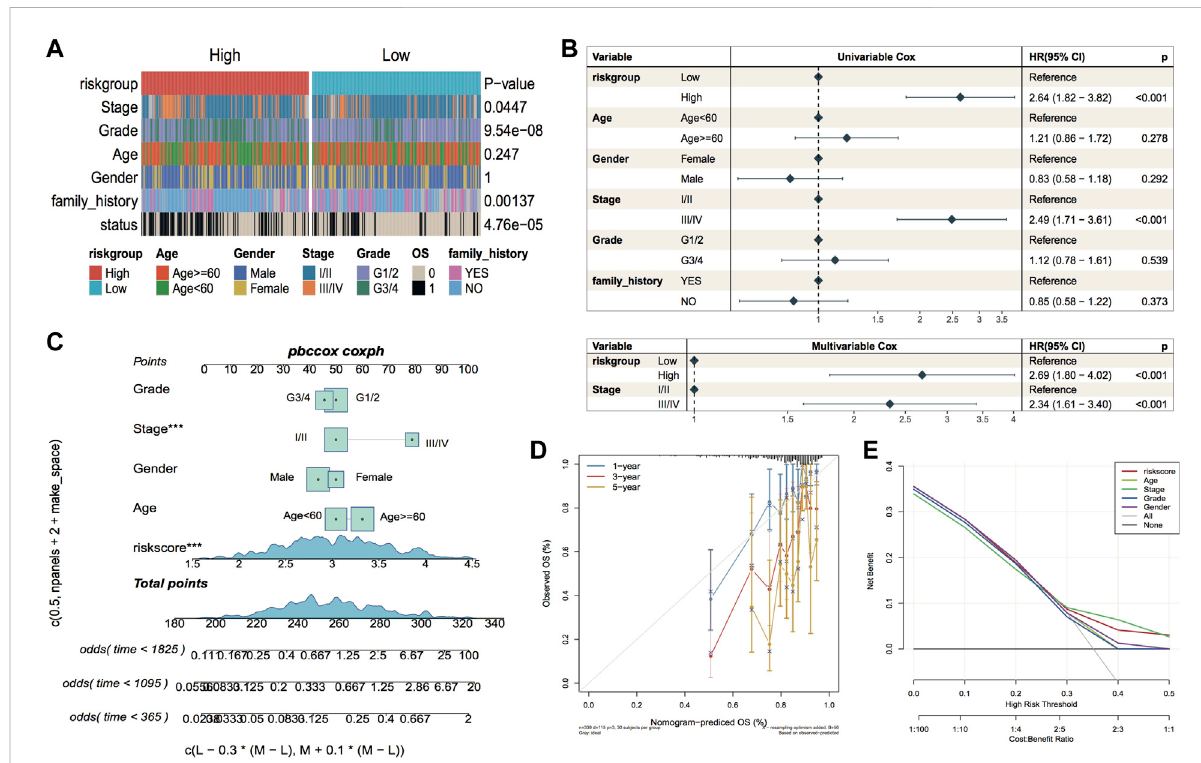
FIGURE 9 Independenceofmodelscoresinclinicalcharacteristics. (A) ThermographicofclinicalcharacteristicsdistributioninLIHCsample,the p -valueis the signi fi cance of the difference between characteristics grouping compared to riskgroup grouping; (B) Forest plot of single-multivariate cox analysis of clinical factors in TCGA cohort; (C) Nomogram of the predictive model, the square plus line segment represents the size of the contribution of the clinical factor to the outcome event. Total Points represents the total score of all variables taken after the corresponding individual scores are addedtogether, and thebottom threelines represent the probability of survival at1,3, and 5 years corresponding to each taken point; (D) Calibration curve, the horizontal coordinate is the predicted probability, the vertical coordinate is the actual probability, the closer to the middlegraylinerepresentsthemoreaccuratepredictedriskprobability,belowthegraylinerepresentstheunderestimatedrisk,aboveThelowerpart of the gray line represents an underestimation of risk and the upper part represents an overestimation of risk. (E) Decision Curve Analysis for nomogram and other